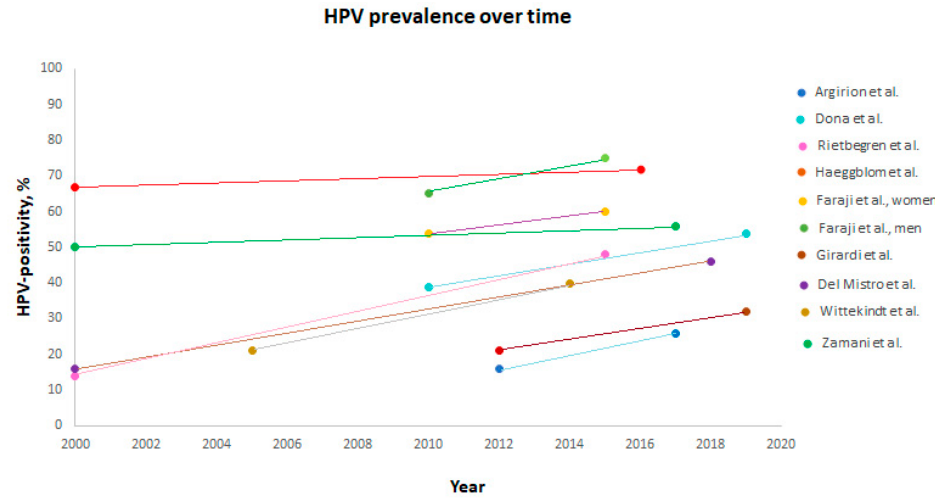
Figure 3. HPV-positivity in patients with OPSCC over time worldwide. OPSCC: oropharyngeal squamous cell carcinoma. HPV: human papillomavirus.